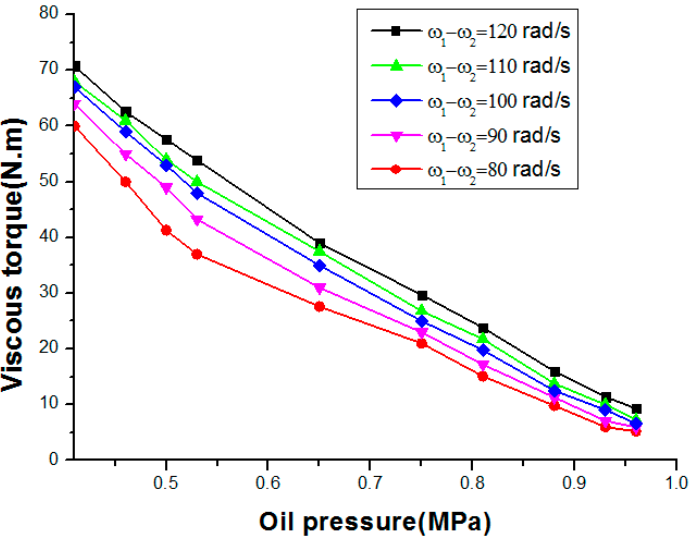
Figure 14. Overall torque characteristic of HVC. Table 3. Experimental data related to the overall viscous torque.